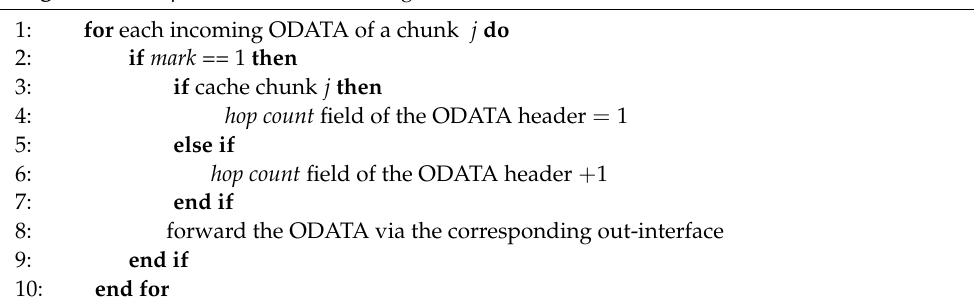
Algorithm 2 Hop Count Field Processing in the